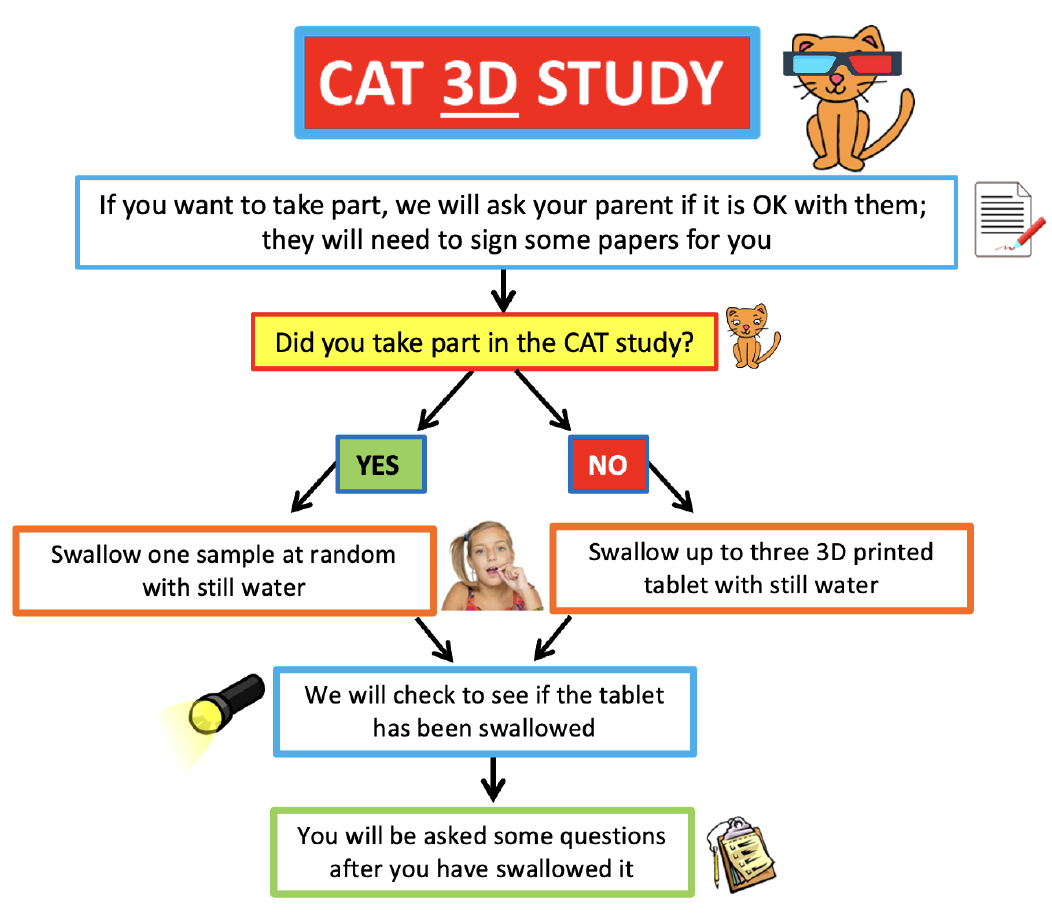
Figure 1. Flow chart of acceptability trials of film-coated and 3D printed tablets.